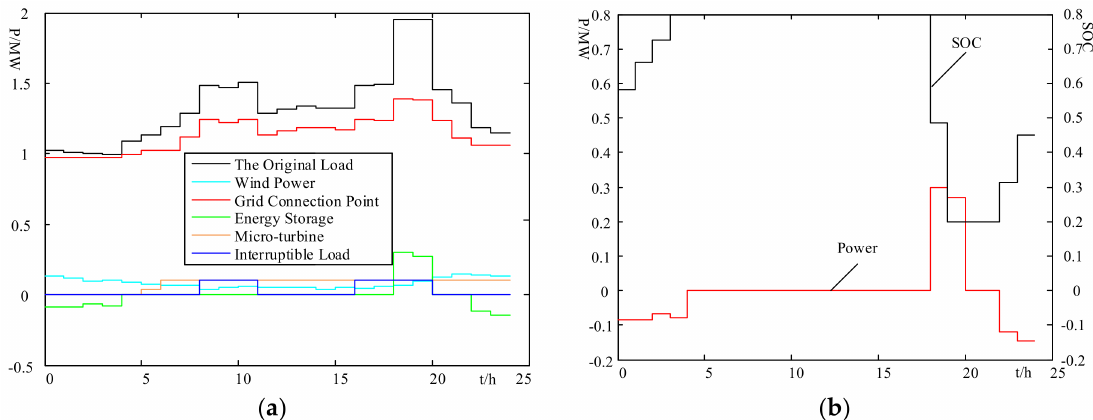
Figure 9. Results of day-ahead optimal dispatch with Strategy 2: ( a ) Power curves of each device; ( b ) state of the